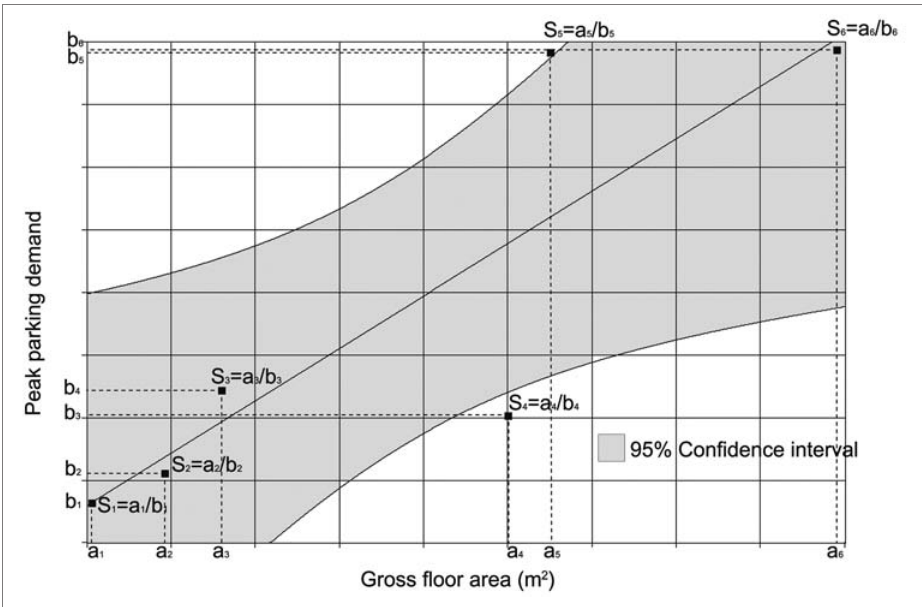
Fig. 4. Example of selected surveyed developments which will serve as the basis for defining the basic